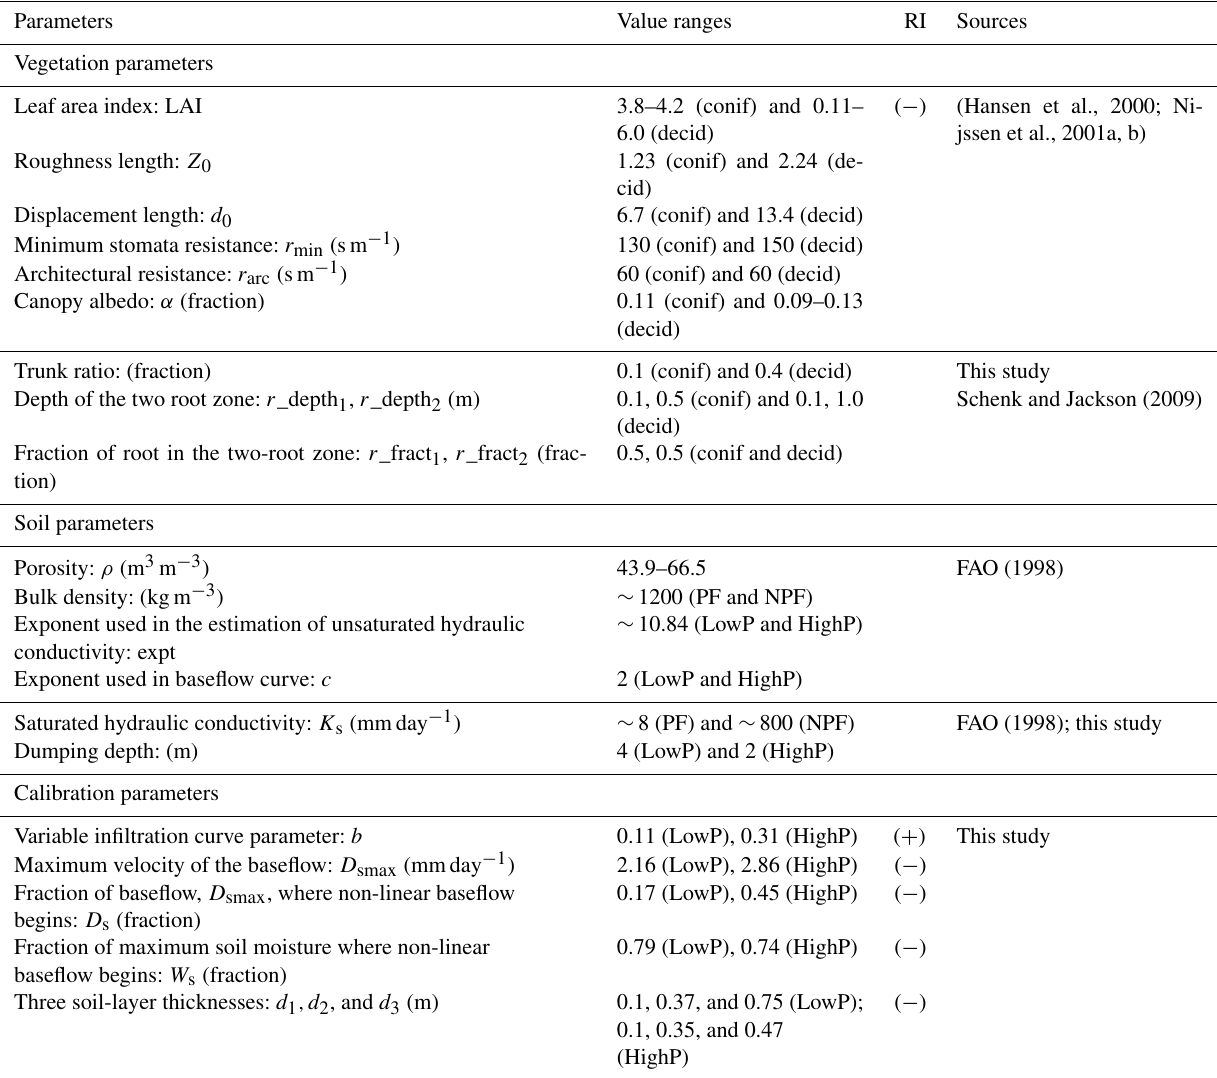
Table 2. Selected vegetation and soil parameters, their values and estimating methods or sources: runoff influence (RI) – runoff increases when parameter values increase ( + ) and runoff decreases when parameter values increase ( − ), coniferous vegetation (conif), deciduous vegetation (decid), permafrost-underlain soil (PF), permafrost-free soil (NPF), parameter values specifically for the LowP sub-basin (LowP), and parameter values specifically for the HighP sub-basin